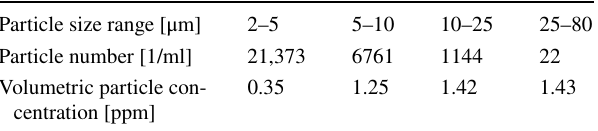
Table 3 Particle size distribution in suspension flowing into the filter during the experiments Particle size range